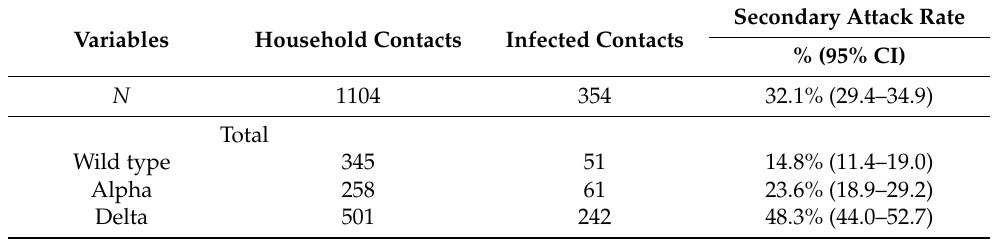
Table 5. Secondary attack rate among unvaccinated household contacts with age ≤ 59 by virus type.